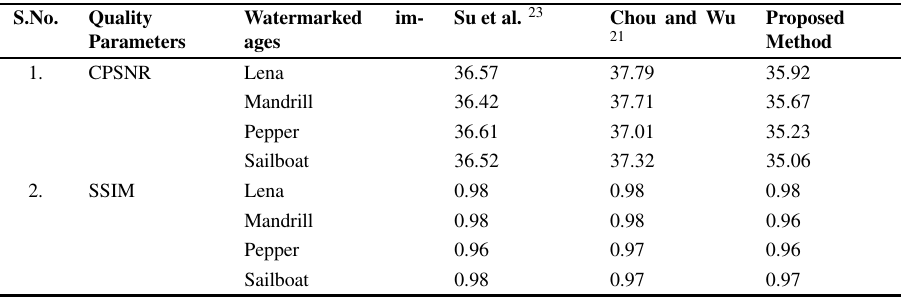
Table 1: Comparison of CPSNR and SSIM values of watermarked images resultant from proposed and considered